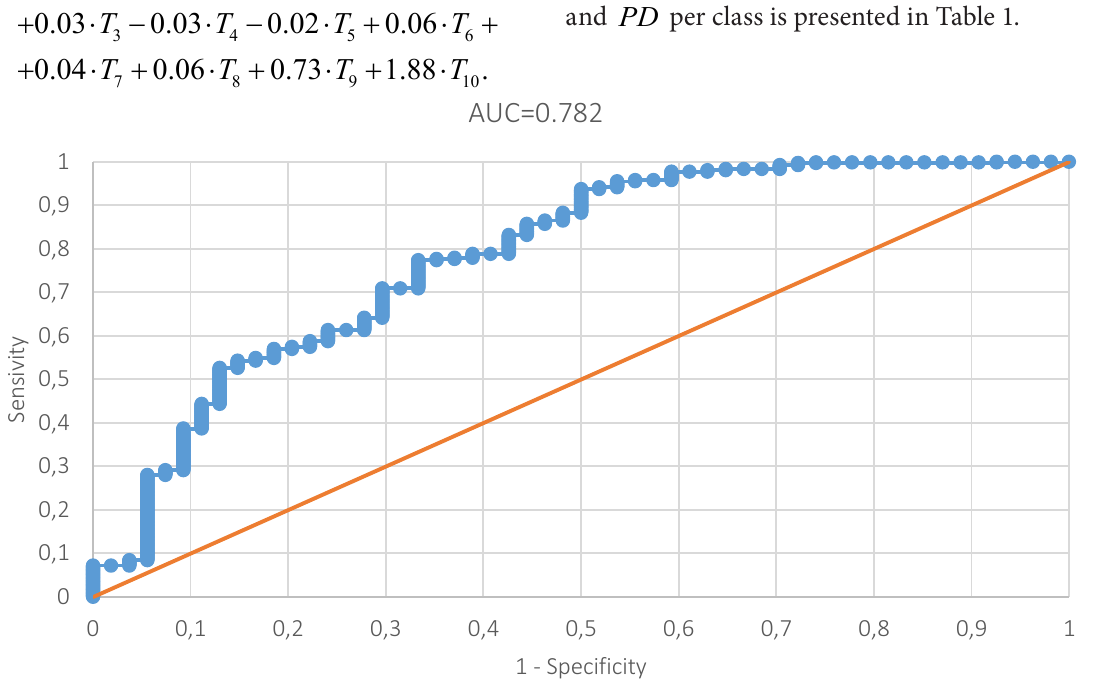
Figure 2. Discriminatory power LDA ( ROC